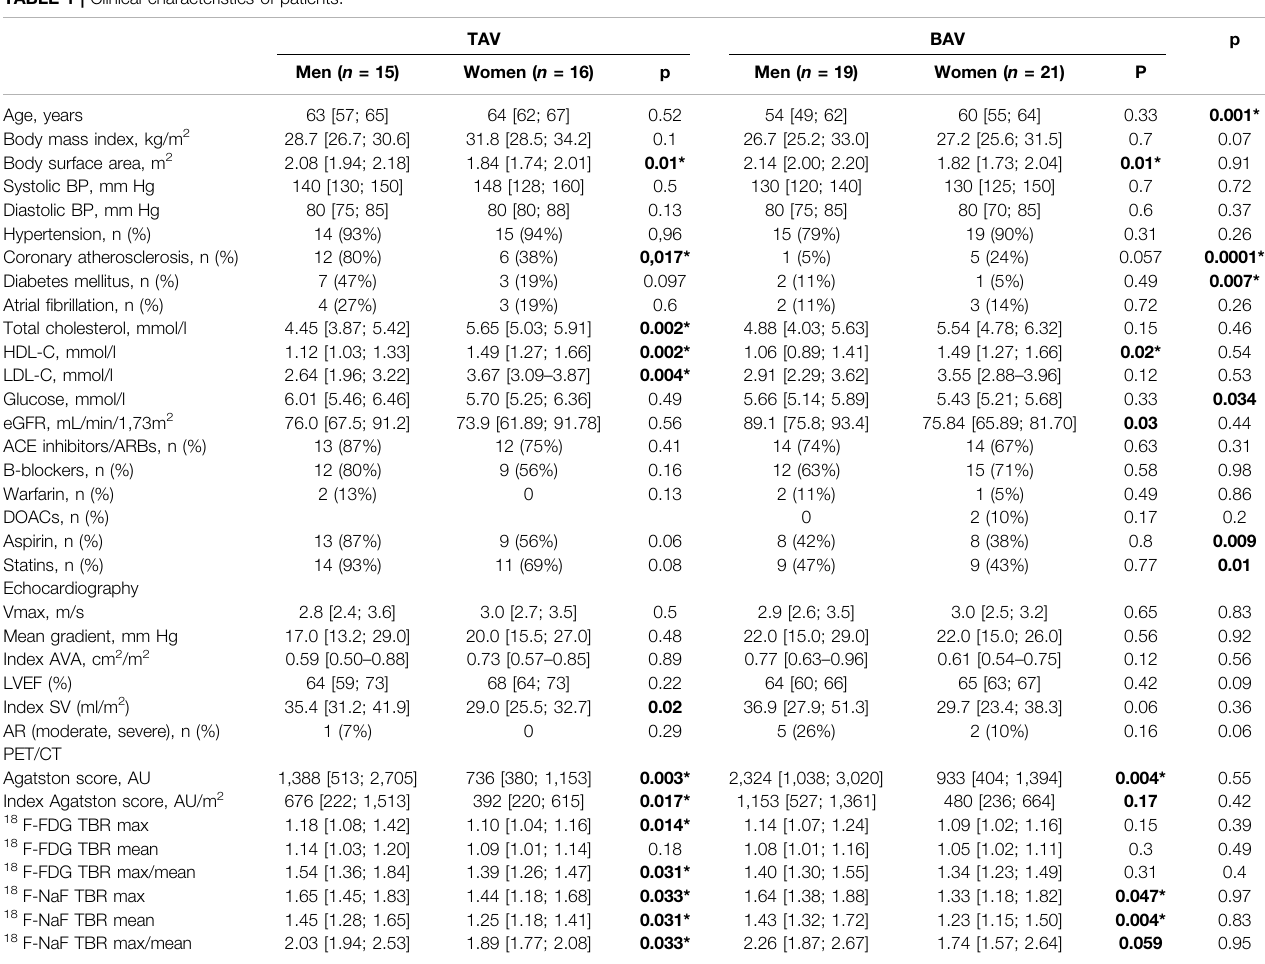
TABLE 1 | Clinical characteristics of